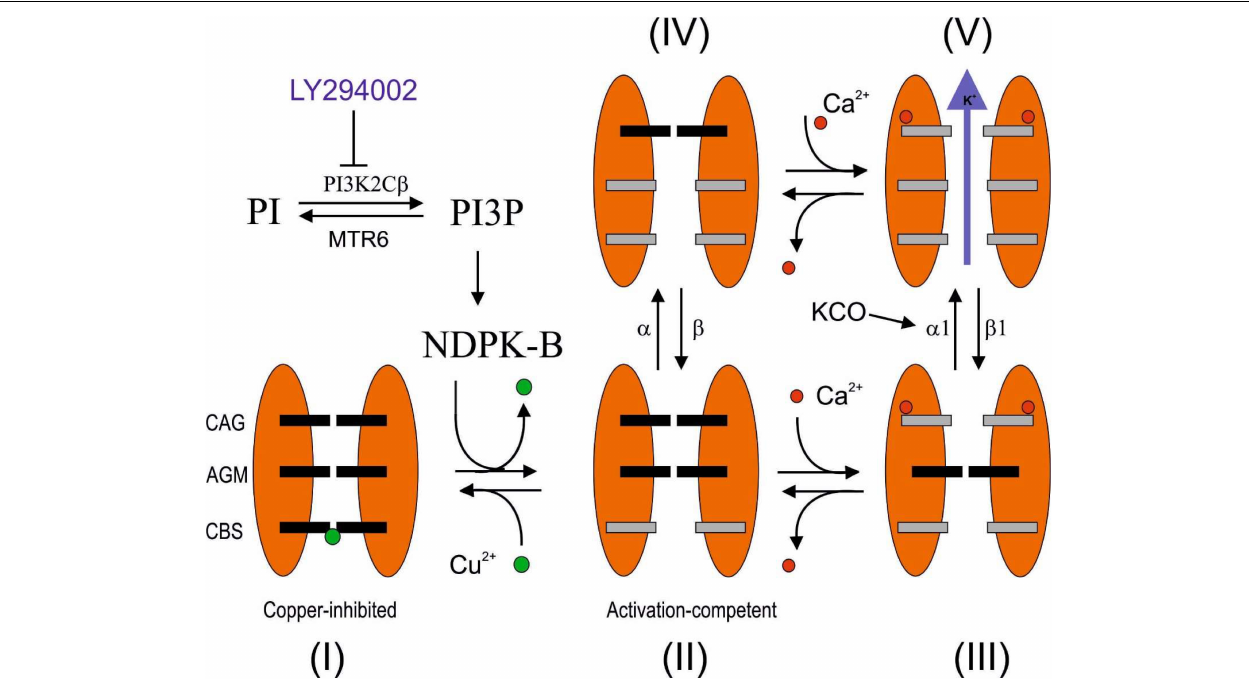
FIGURE 5 | Hypothetical LY294002 inhibition mechanisms of KCa3.1 channel. The channel is described by three gates and five states (Manfroni et al., 2020). The state I is characterized by the affinity for the Cu 2 + blocker, which is regulated by the histidine phosphorylation promoted by PI3KC2 β /NDPK-B pathway and sensible to the LY294002 inhibition. In the absence of calcium, the relative occupancy of III and V is not relevant, whereas at calcium saturating concentration, the relative occupancy of II and IV turns out to be negligible. In this study, we reported three conditions at calcium saturating concentration. (1) In the absence of inhibitors, the P OPEN is 0.4 since the only two possible states are III and V, and the (cid:49) E of V with respect to III is estimated to be 1 kJ/mol, according to the Boltzmann equation. (2) In the presence of LY294002 inhibition, the P OPEN is 0.2. Assuming that the difference in enthalpy between III and V is 1 kJ/mol (refer to the abovementioned details), the state I has been estimated to be the most stable with respect to III and V by 2.25 and 3.25 kJ/mol, respectively. (3) After the addition of KCO, with or without inhibitors, the P OPEN is 0.8, indicating that V is the most stable state with enthalpy change by at least 3.4 kJ/mol with respect to III and I. A possible explanation that reconciles how the P OPEN at the saturated calcium concentration moves from about 0.2 or 0.4 to 0.8, regardless of the inhibition by LY294002, could be justified by the stabilization of V by 4.25 kJ/mol with respect to I and 6.5 kJ/mol with respect to III (the energetics of I and III remains steady). The stabilization of V could be the consequence of the increasing of the direct constant rate α 1 or the decreasing of the inverse constant rate β 1 . MTR6: myotubularin-related protein 6 (Srivastava et al.,